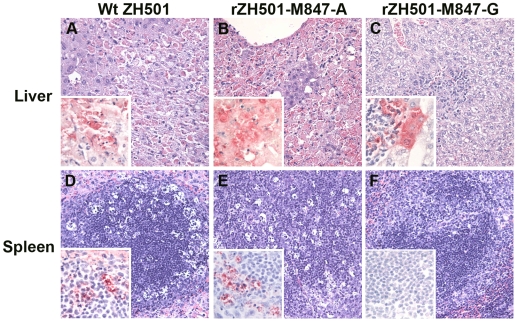
Histopathology and immunohistochemistry (IHC) of mice infected with ZH501 (A and D), rZH501-M847-A (B and E) and rZH501-M847-G (C and F).(A) Liver histopathology and IHC (inset) from mice infected with ZH501 on day 3 p.i. The majority of the hepatocytes were necrotic (hematoxylin and eosin staining) (magnification, ×200, inset: ×400). (B) Liver histopathology and IHC (inset) from mice infected with rZH501-M847-A on day 3 p.i. The samples showed severe hemorrhages in the livers due to disrupting hepatocytes (magnification, ×200, inset: ×400). (C) Liver histopathology and IHC (inset) from mice infected with rZH501-M847-G on day 3 p.i. Mice had focal necrosis in the liver (magnification, ×200, inset: ×400). (D) Spleen histopathology and IHC (inset) from mice infected with ZH501 on day 3 p.i. Depletion of lymphocytes in the white pulp was present (magnification, ×200, inset: ×400). (E) Spleen histopathology and IHC (inset) of mice infected with rZH501-M847-A. The lesion was the same as that of ZH501-infected mice (magnification, ×200, inset: ×400). (F) Spleen histopathology and IHC (inset) of mice infected with rZH501-M847-G (magnification, ×200, inset: ×400). No lesions or viral antigens were detected in the spleens of mice infected with rZH501-M847-G.